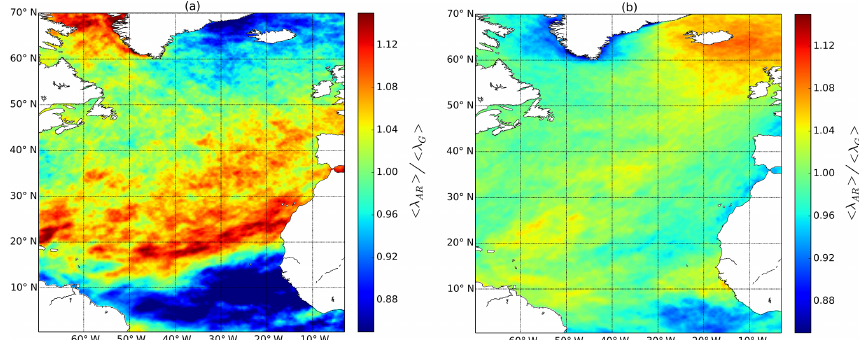
Figure 6. Ratio of the FTLE backward time series consisting of periods with land-falling atmospheric rivers and the global backward FTLE mean (Fig. 1c) for Saharan Morocco (a) and the UK and Ireland (b)